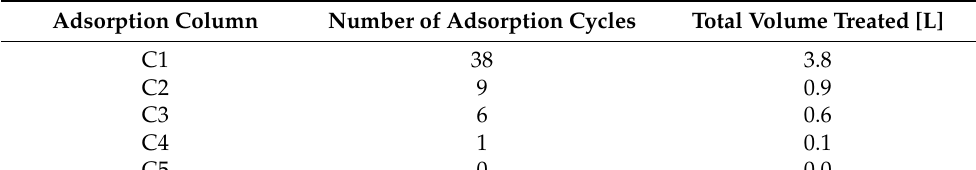
Table 2. Number of adsorption cycles of 100 mL of Reactive Black 5 [37 mg/L] solution and total